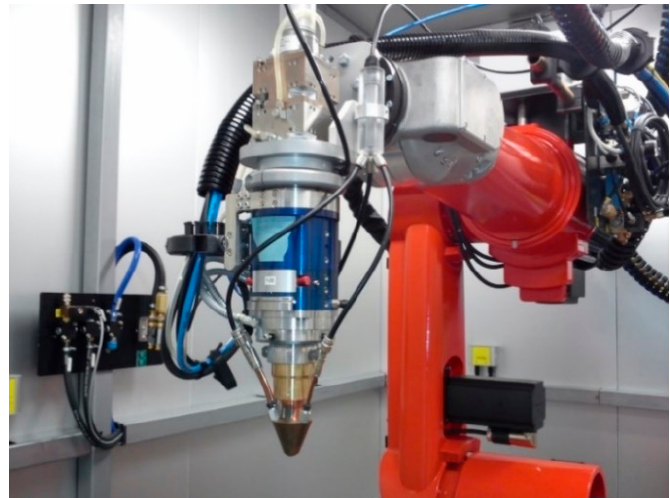
Figure 2. Applied fibre laser.